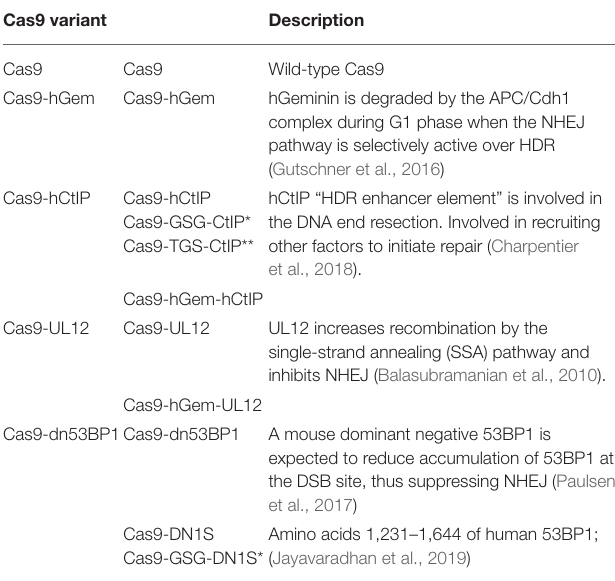
TABLE 2 | Panel of Cas9-fusion variants assessed in this